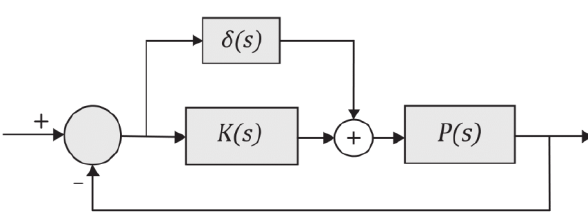
Figure 2. Block diagram of closed-loop system 𝑯 𝒍,𝒓 (𝒔) [20].